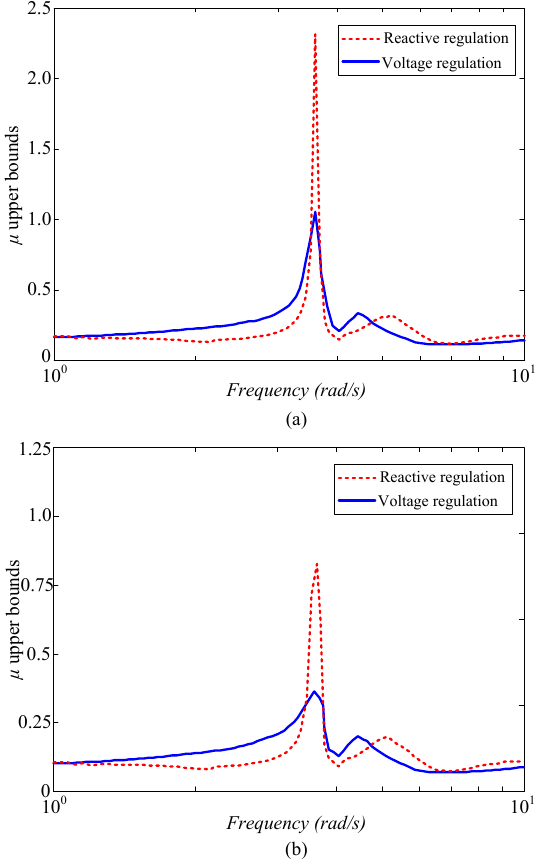
Figure 7. The uncertain bounds of reactive power regulation and voltage regulation. ( a ) Open loop; ( b ) close